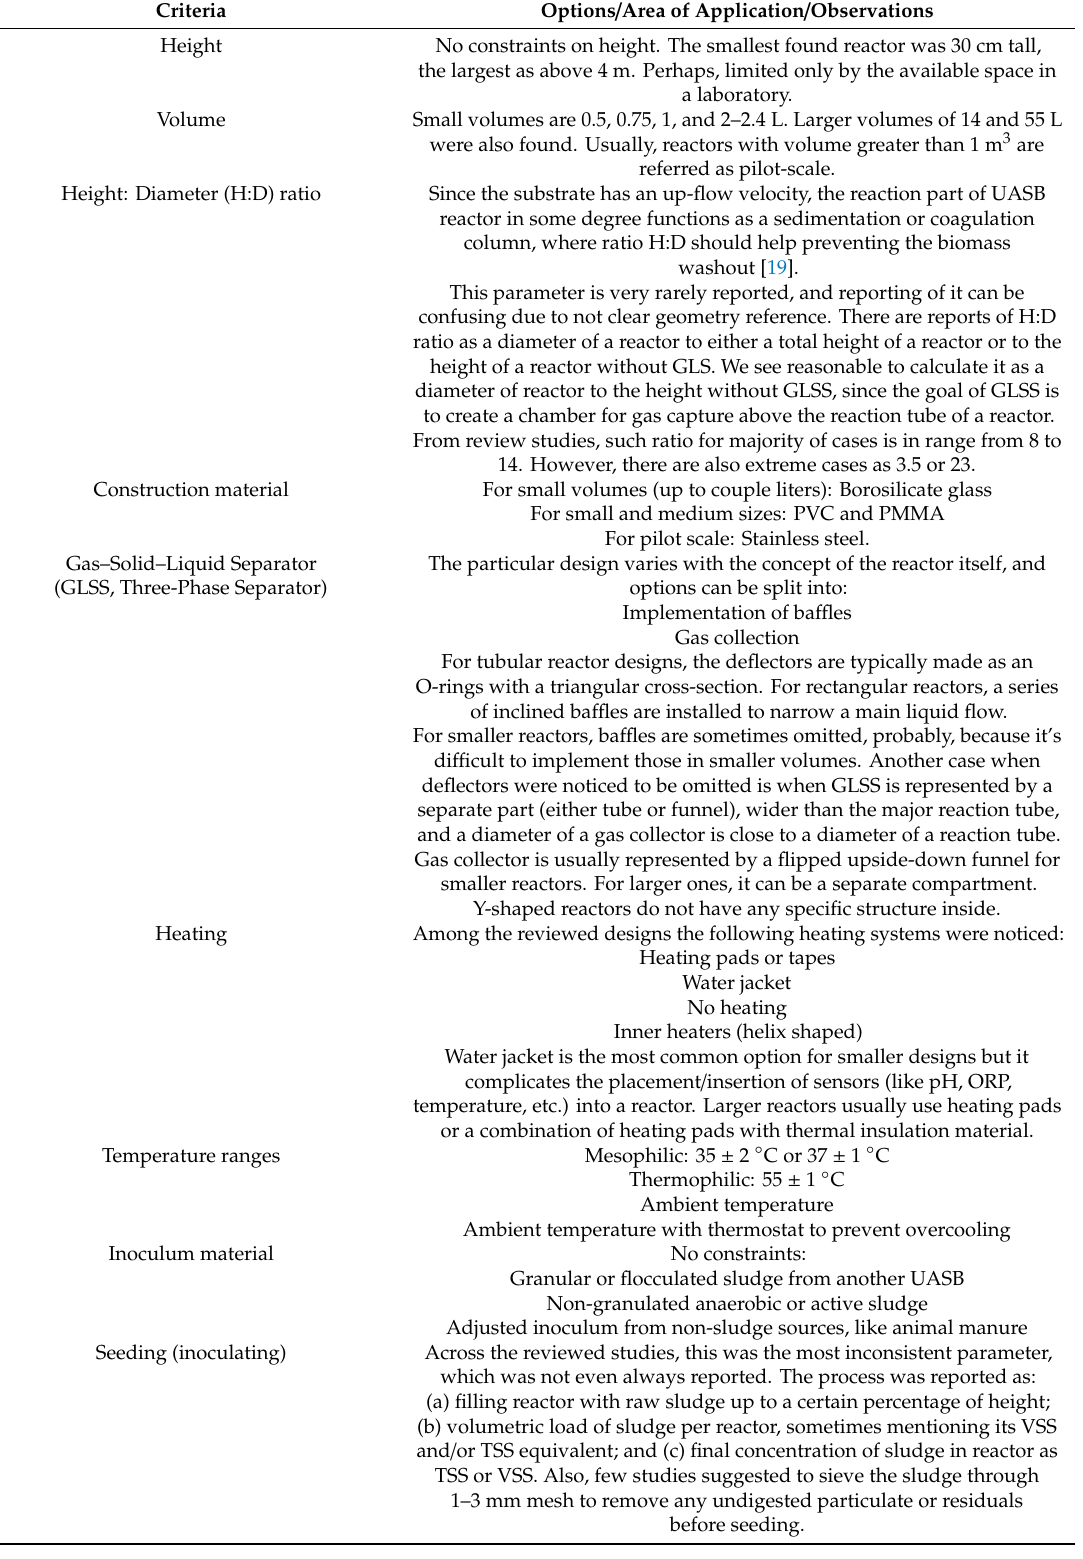
Table 4. Summary of the geometry and operational parameters for existing UASB reactor